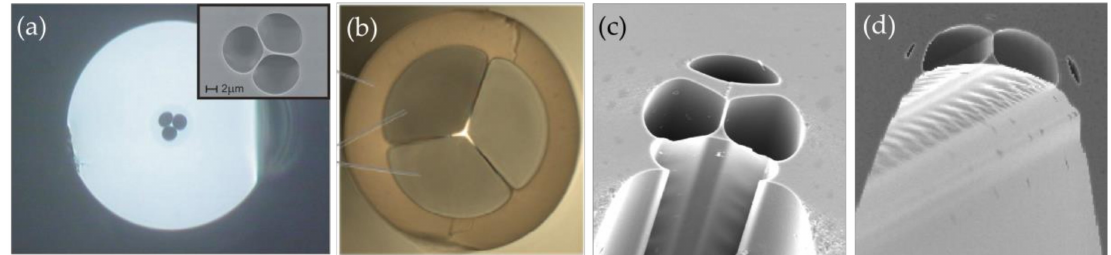
Figure 5. ( a , b ) Cross-section images of suspended core photonic crystal fibers (SC-PCFs) with triangular-like microcores [53,58]. ( c , d ) Cross-section images of exposed-core SC-PCFs fabricated by etching the drawn fiber and drawing from the drawing tower [112]; the image sizes are 40 µ